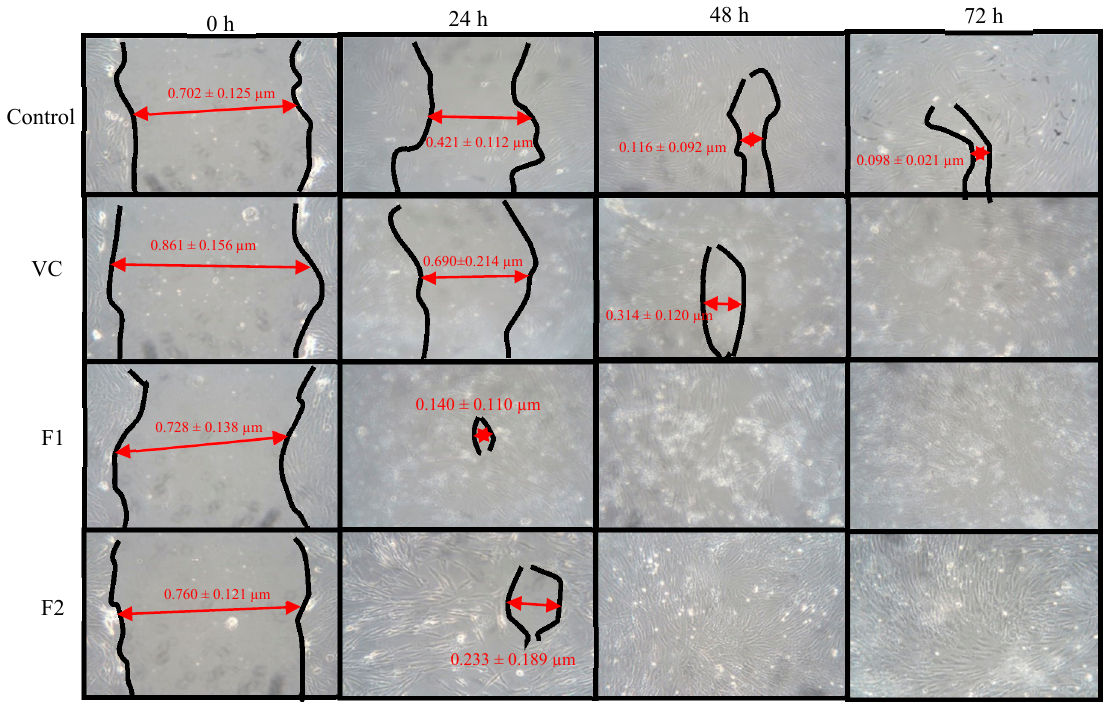
Figure 7. Cell migration analysis.